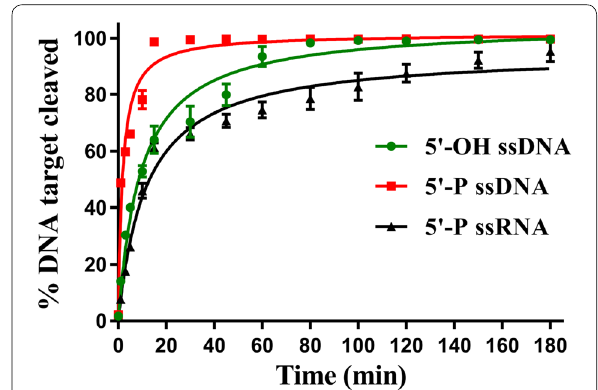
Fig. 7 Kinetic performance of Mf Ago mediated by three different kinds of guides. Assays were performed in three independent experiments and plotted using nonlinear regression. SDs are represented by error bars